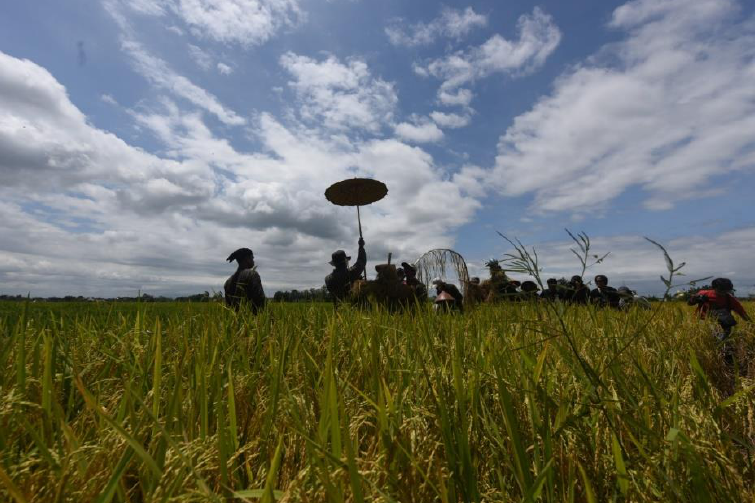
Fig. 2 The society of Delanggu area, Klaten, Central Java held Tayub performance (Credit Photo: Ade